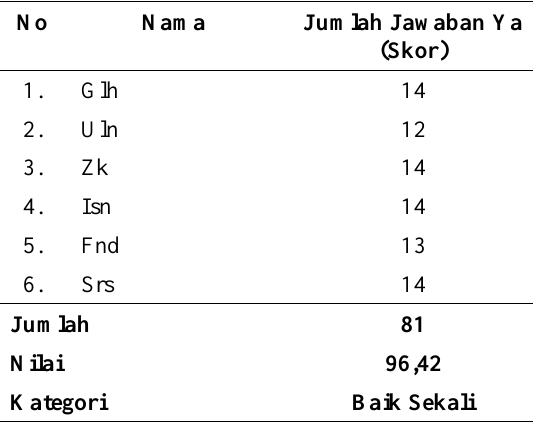
Tabel 2. Data hasil angket respon